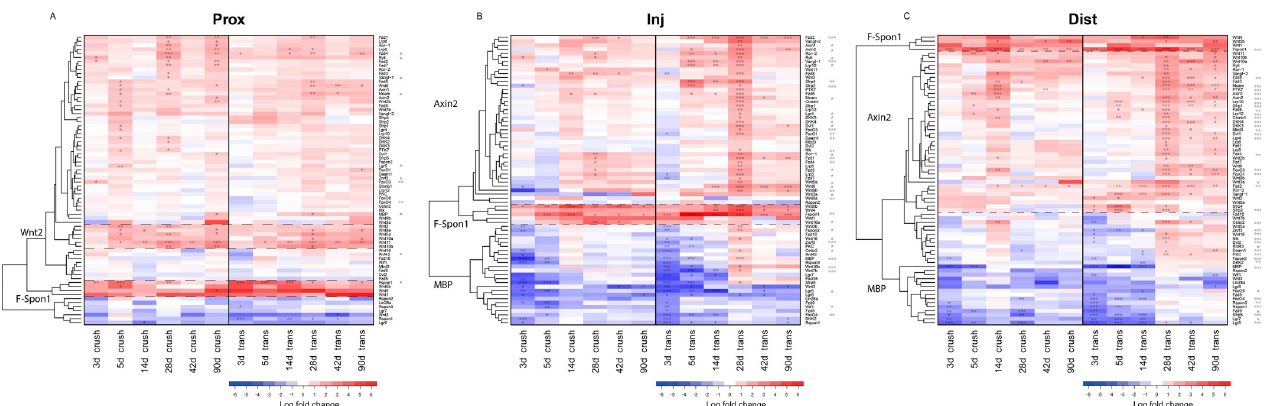
Fig 3. Changes in the expression of Wnt pathway genes after peripheral nerve injury in the rat. The expression of 72 Wnt pathway genes in crushed (left half of the figure) and transected (right half of the figure) rat nerve (3 to 90 days post injury) was analysed using qPCR. Data is presented as clustered heat maps for the proximal stump (A), injury site (B) and distal stump (C). Red indicates up- and blue down-regulation of mRNA expression of the analysed genes compared to uninjured control nerve. A , The proximal stump displays two clusters of co- regulated genes, the Wnt2 and F-Spondin cluster. B , C , the injury site (B) and distal nerve stump (C) exhibit three clusters of genes, the F-Spondin cluster, the axin-1 cluster and the MBP cluster. All corresponding fold changes and SEM are provided in S2–S4 Tables. Asterisks indicate significant timepoints, asterisks behind gene names indicate significant effects of injury on the gene expression profile ( � p < 0.05, �� p < 0.01, ��� p < 0.001).